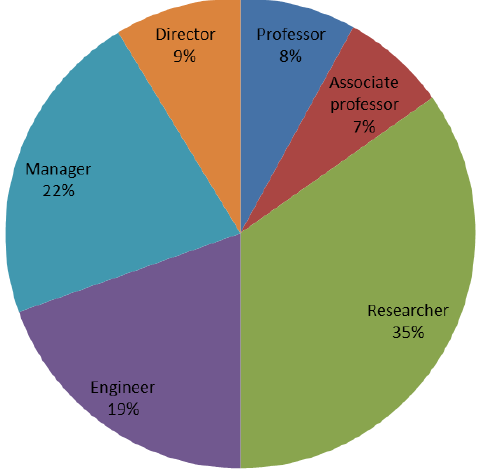
Figure 7: Current work positions for doctoral students using the ¨Asp¨o hard rock laboratory